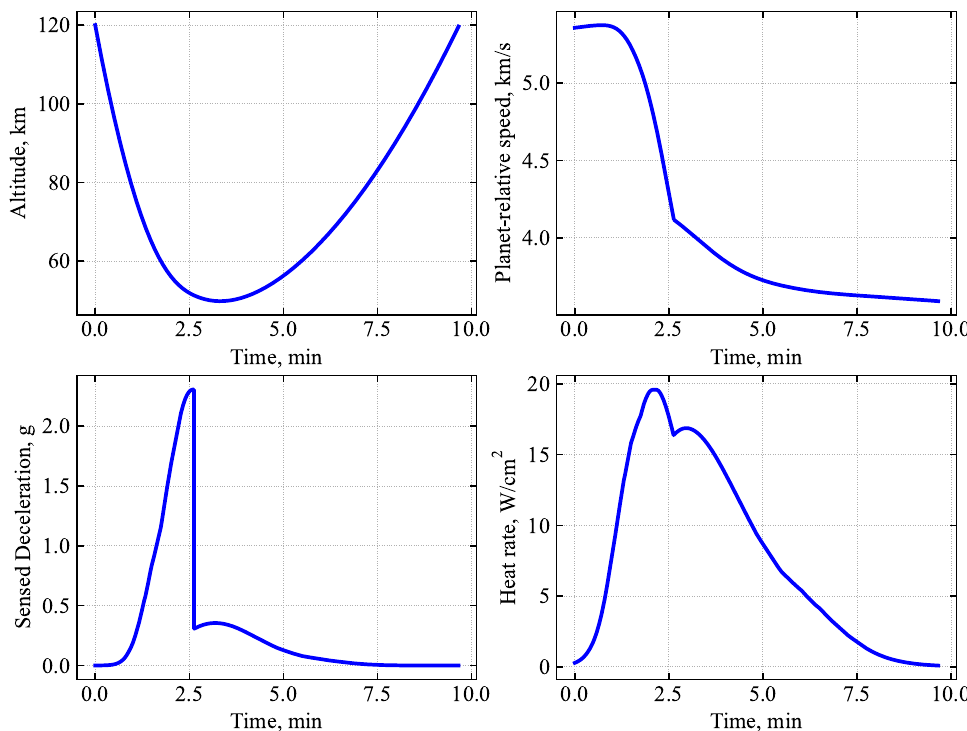
Figure 7. Nominal Mars small satellite aerocapture trajectory for a vehicle with β 1 = 20 kg/m 2 , β 2 / β 1 = 7.5, R N = 0.235 m entering at atm. relative EFPA = − 9.25 deg. Target apoapsis = 2000 km.